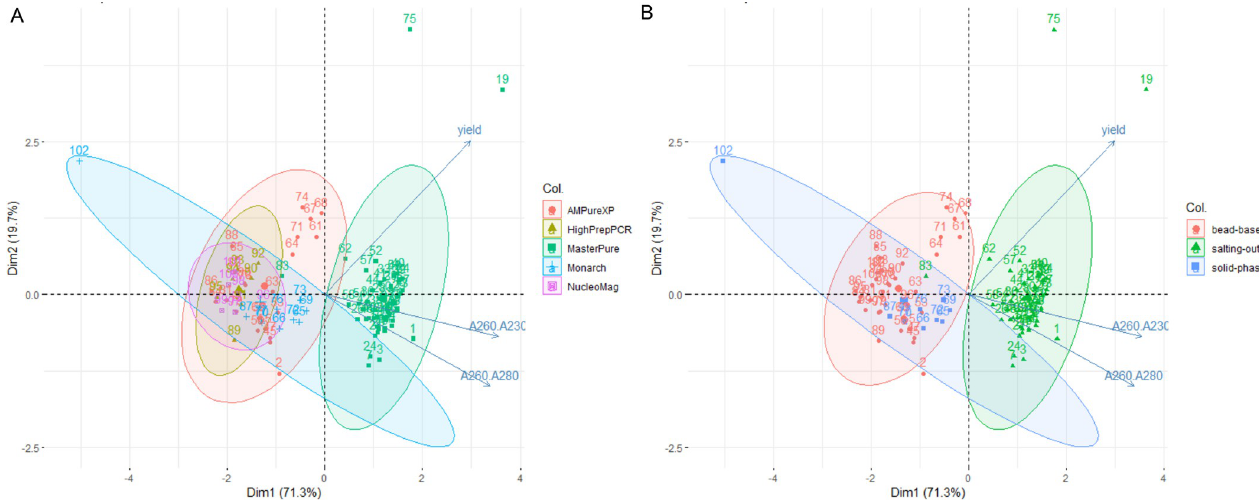
Fig 1. PCA biplot analysis on DNA yield and quality recovered from STEC strains depending on (A) extraction kits and (B) method.